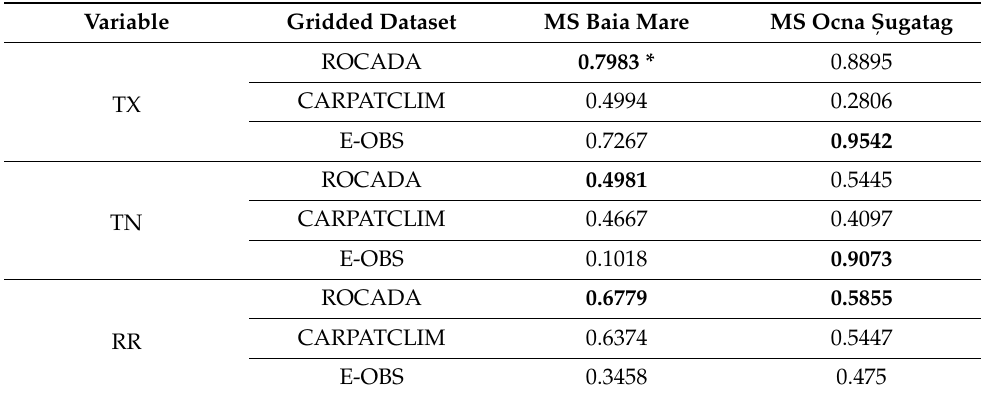
Table 5. Pearson’s correlation coefficient between gridded and observation data series for the 99th percentile values for TX, TN, and RR (1961–2010).